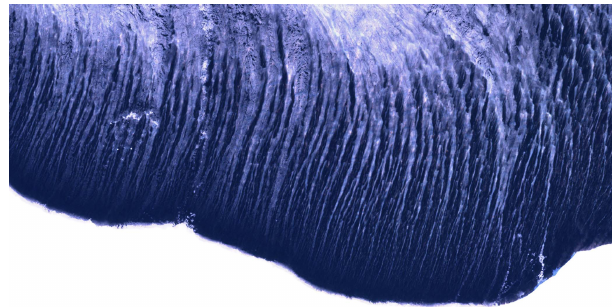
Figure 1. Sentinel-2 L1C image acquired on 10 March 2018 show- ing frazil streaks forming off the Ross Ice Shelf, Antarctica (im- age size ca. 13km × 6km, centered at 77.4 ◦ S, 173.3 ◦ E). Source: https://www.sentinel-hub.com/ (last access: 2 November